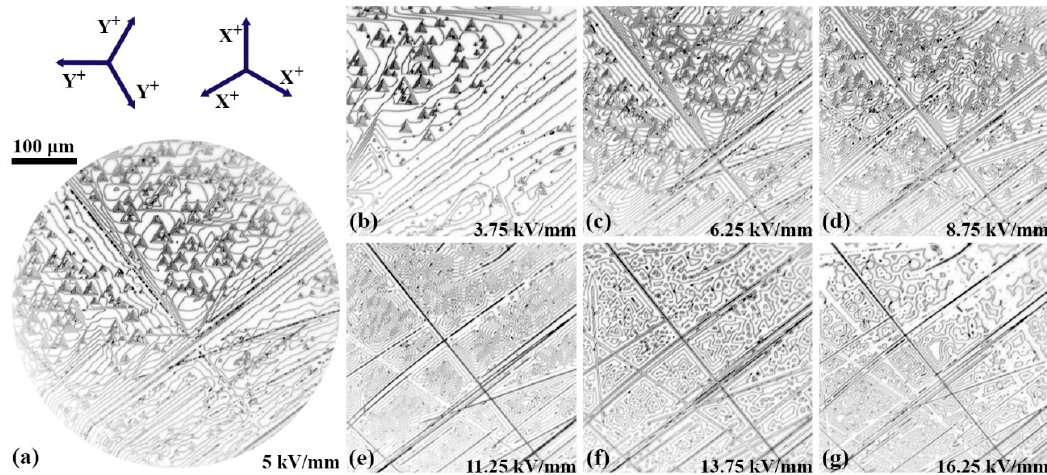
Figure 3. ( a ) The kinetic map of the polarization reversal process for the whole image area. The time interval between subsequent wall positions was 45 s. ( b – g ) Central fragments of the kinetic maps for various field values. Time intervals between the subsequent wall positions, s: ( b ) 160, ( c ) 15, ( d ) 5, ( e ) 1.75, ( f ) 1.25, and ( g ) 0.12.